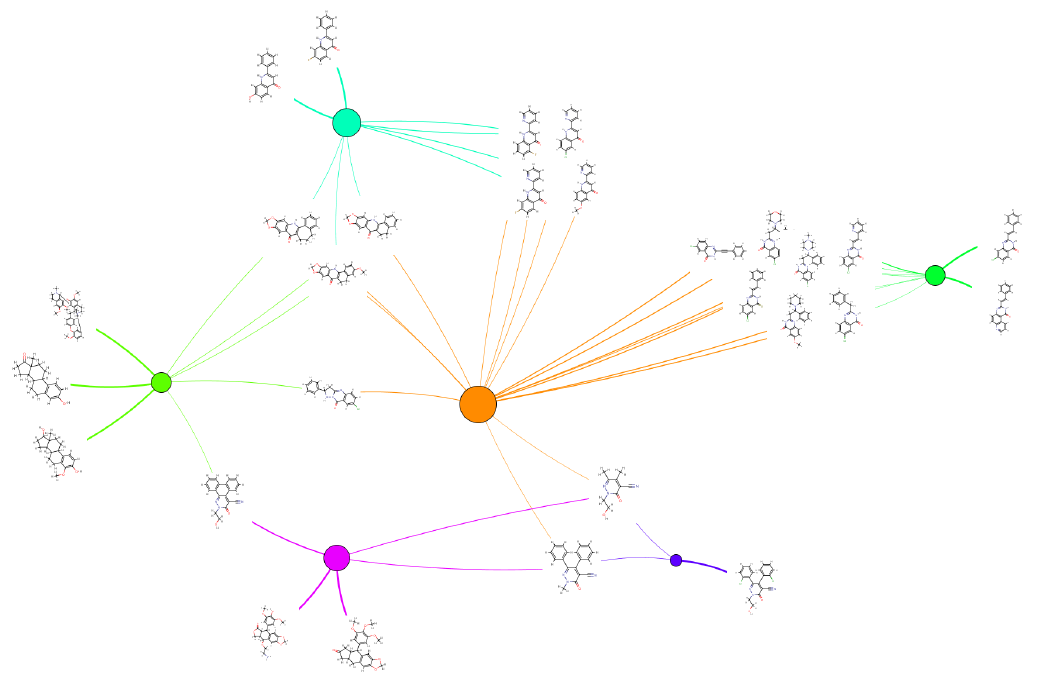
Figure 19: The final network as displayed by KNIME. One can nicely see how a couple of molecular structures fall clearly within one cluster. Others, however, belong to more than one cluster and have therefore substantial connections to more than one cluster